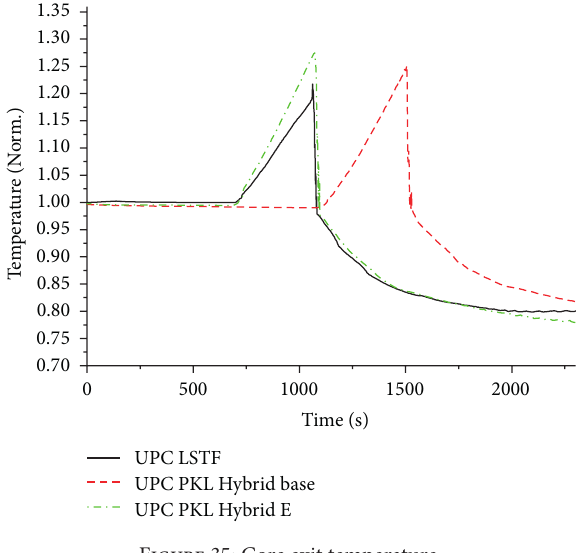
Figure 33: Core exit temperature.